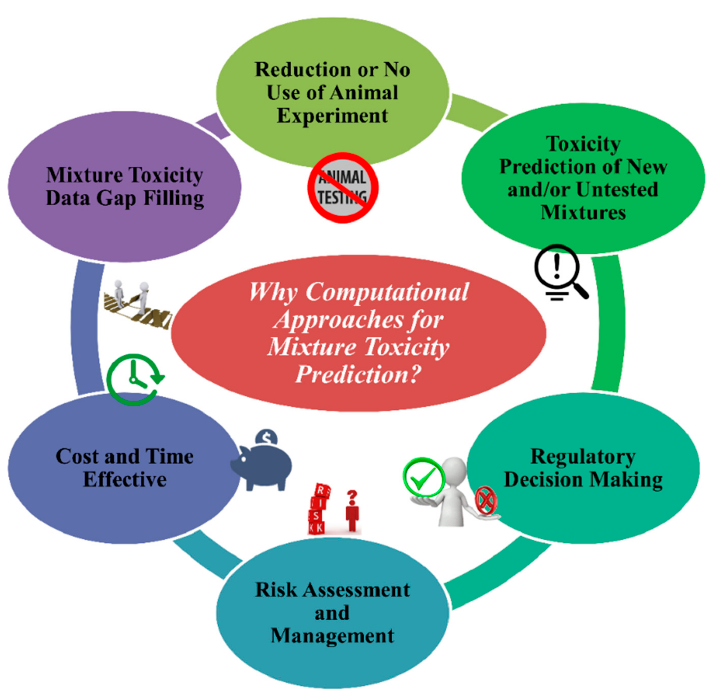
Figure 2. The reasons behind the implication of computational approaches for a mixture’s toxicity prediction.